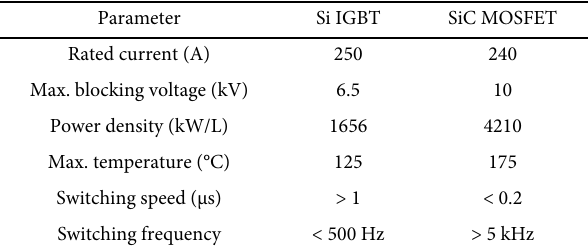
Table 1 Comparison between Si IGBT and SiC MOSFET for MV applica- tions Parameter Si